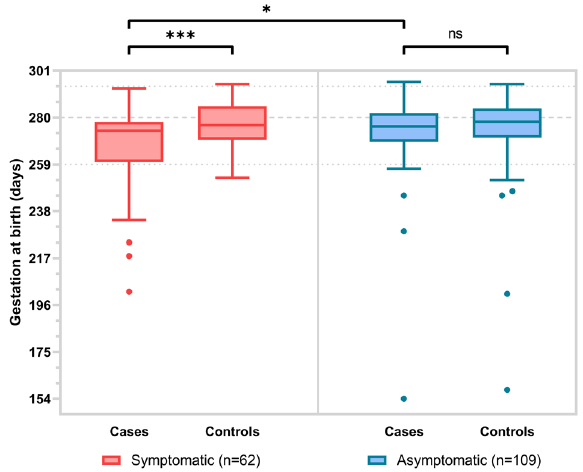
Figure 3. The distribution of gestation at birth for COVID-19 cases and matched controls, grouped by symptom status. Boxes represent the median and interquartile range, whiskers show the Tukey fences and closed circles show outliers. The dashed reference line is given at 40 + 0 weeks, with dotted lines at 37 + 0 and 42 + 0 weeks gestation. * p < 0.05, *** p < 0.001, ns Not